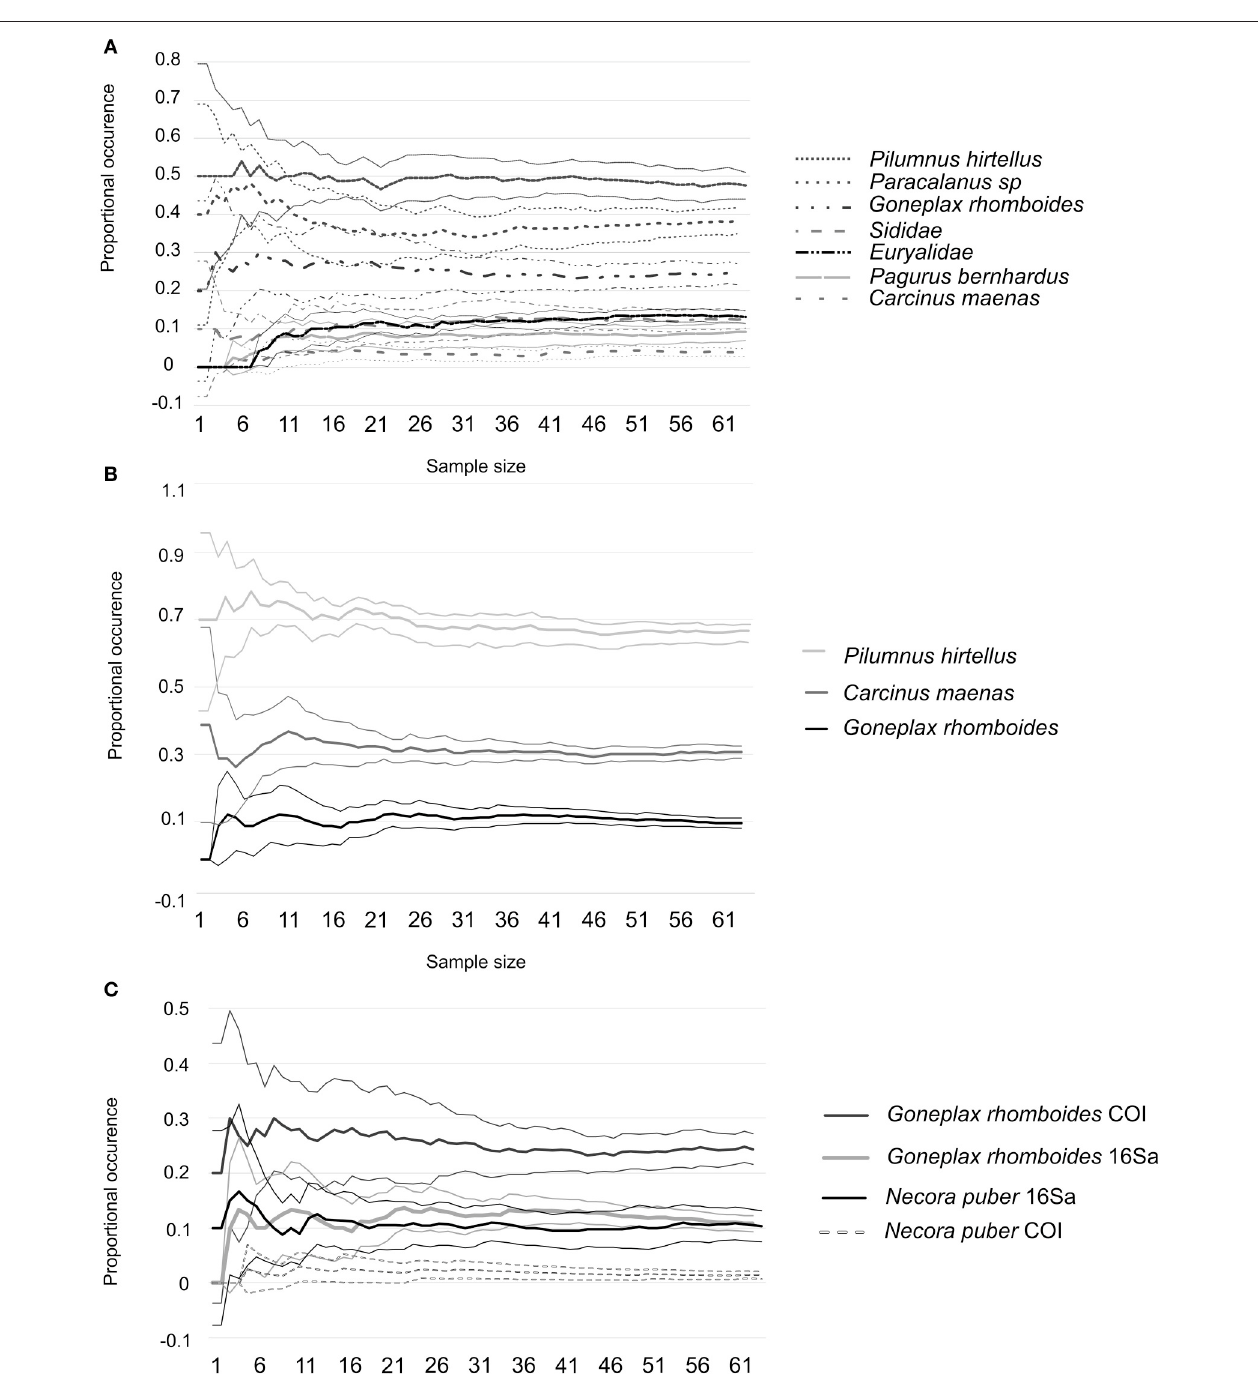
FIGURE 8 | Summary from 10 randomized sample sets of species identified in O. vulgaris with primers COI (A), primers 16Sa (B) , and both pair of primers (C) . Average values are presented as continues lines and Confidence Intervals (C.I.) as dashed lines.